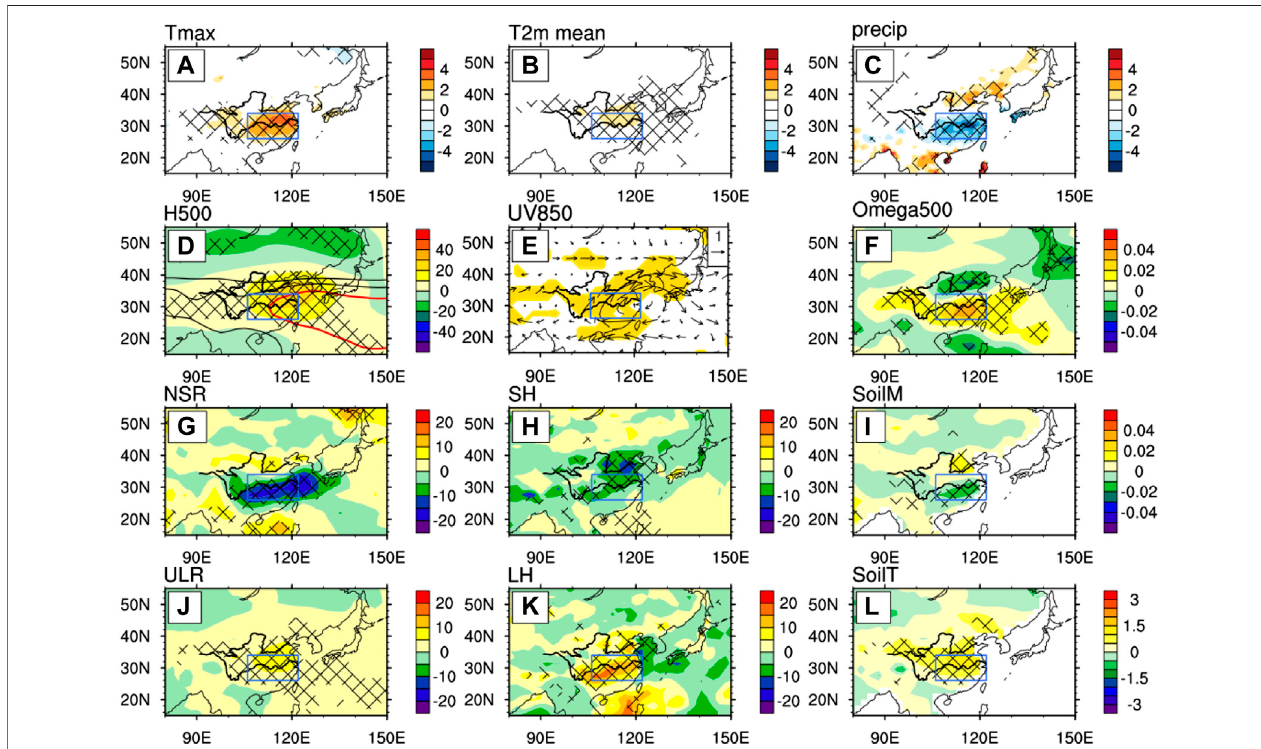
FIGURE6 | Compositeofanomalous atmosphereand soil variables interms ofRPHWs inCC that are departures from the long-term climate mean over the whole studyperiod,i.e., T max (unit: ° C) (A) , T 2m (unit: ° C) (B) ,precipitation(unit:mm) (C) ,500 hPageopotentialheight(shading,unit:gpm)andisolinesof588(redcontours),586 and584(blackcontours) (D) ,850 hPawindvector(vector,unit:m s − 1 ) (E) ,500 hPa ω (unit:Pa s − 1 ) (F) ,netshortwaveradiationatsurface(unit:W m − 2 ) (G) ,sensibleheat fl ux(unit:W m − 2 ) (H) ,surfacesoilmoisture(unit:proportion) (I) ,upwardlongwaveradiationatsurface(unit:W m − 2 ) (J) ,latentheat fl ux(unit:W m − 2 ) (K) ,andsurface soil temperature (unit: K) (L) . Where, in radiation (G, J) and heat fl ux (H, K) , positive is upward. The 95% con fi dence level is indicated by the shading in (E) and the hatched area in others.